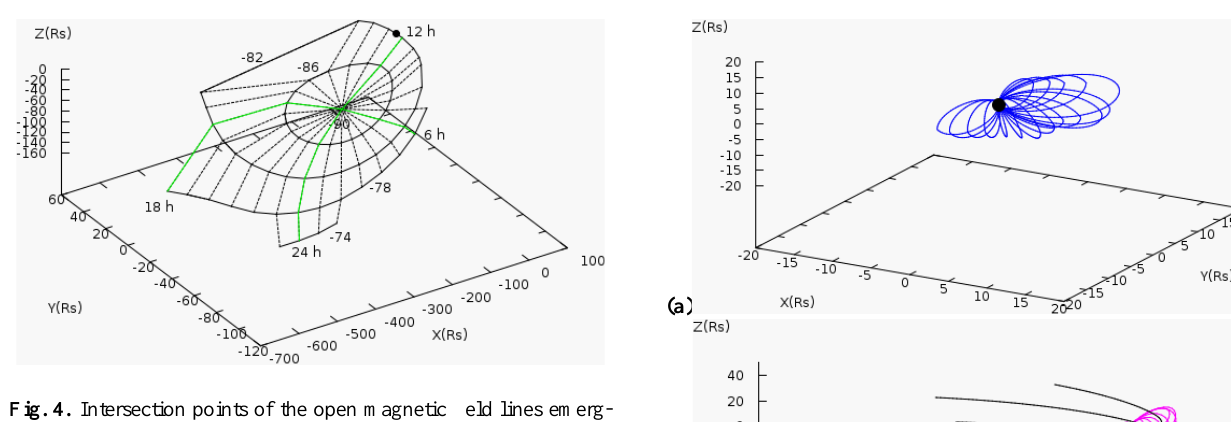
Fig. 4. Intersection points of the open magnetic field lines emerg- ing from Saturn’s southern ionosphere, as shown in Fig. 3, with the southern magnetopause, for the case of image C with k s = 0 . 2. Solid curves show projections along the field of lines of constant ionospheric latitude from − 74 ◦ to − 90 ◦ at steps of 4 ◦ , while dashed lines show projections of lines of constant LT at steps of 1 h, where the green lines show the projections of the principal meridians as marked. The black dot marks the position in the plot of Saturn.